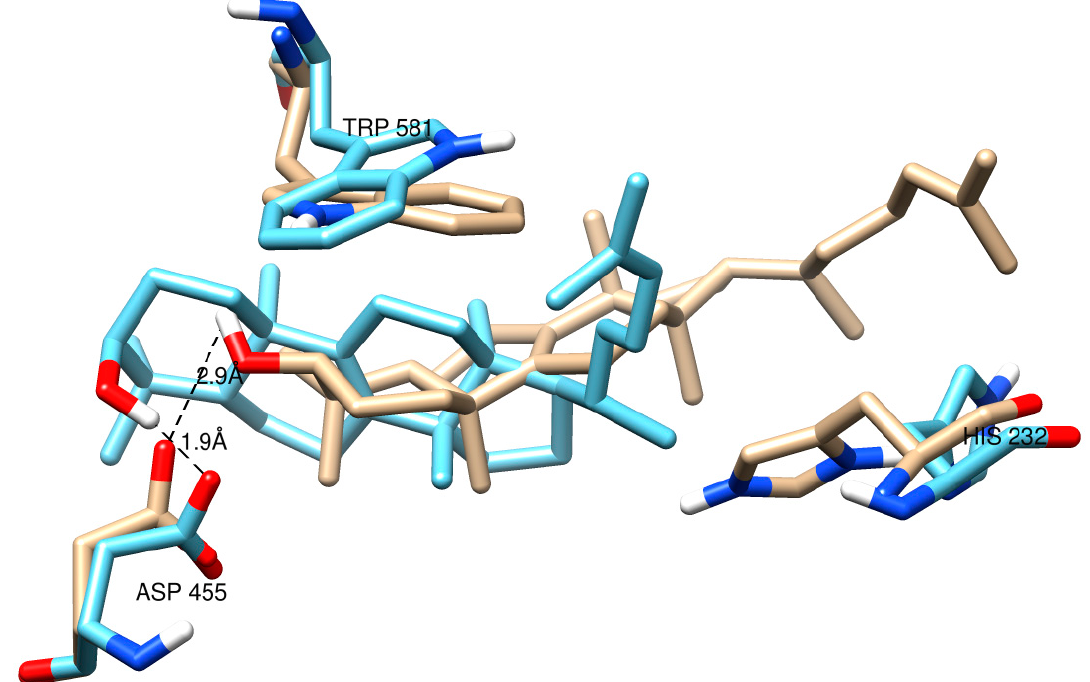
Figure 6. Validity of docking using ROSIE (Rosetta Online Server that Includes Everyone) Ligand Docking. Lanosterol was docked using the human OSC crystal structure (1w6k) without the ligand and then superimposed on 1w6k-lanosterol complex using CZ3 atom of W581 as the docking center. Brown, ligand pose in the crystal structure showing oxygen atom (red) of hydroxyl group; cyan, ligand docked using ROSIE. Hydrogen bonds between lanosterol and D455 (involved in initial protonation of the substrate) are shown for both structures. The deprotonating H232 (lower right) is also